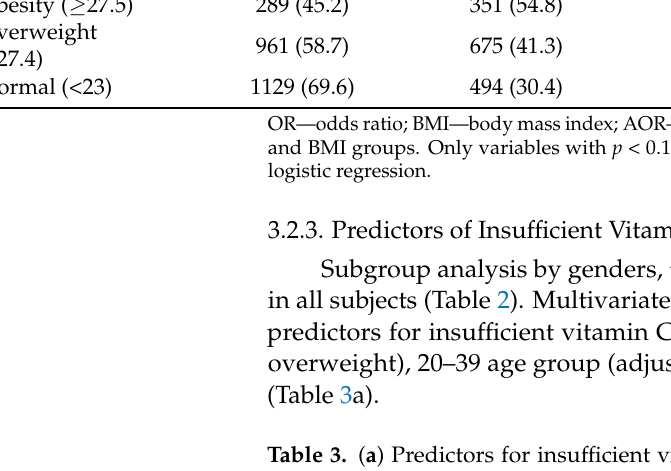
Table 3. ( a ) Predictors for insufficient vitamin C levels (<50 µ mol/L, ≤ 8.8 mg/L) among